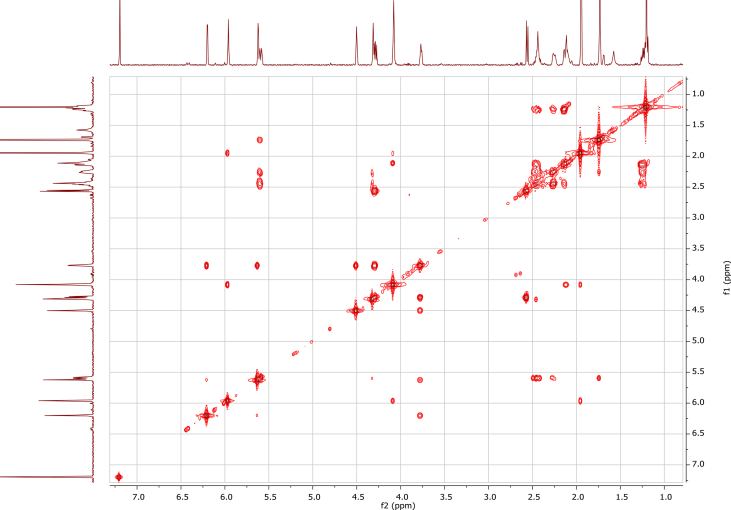
HH-COSY (CDCl3) spectrum of compound 5.